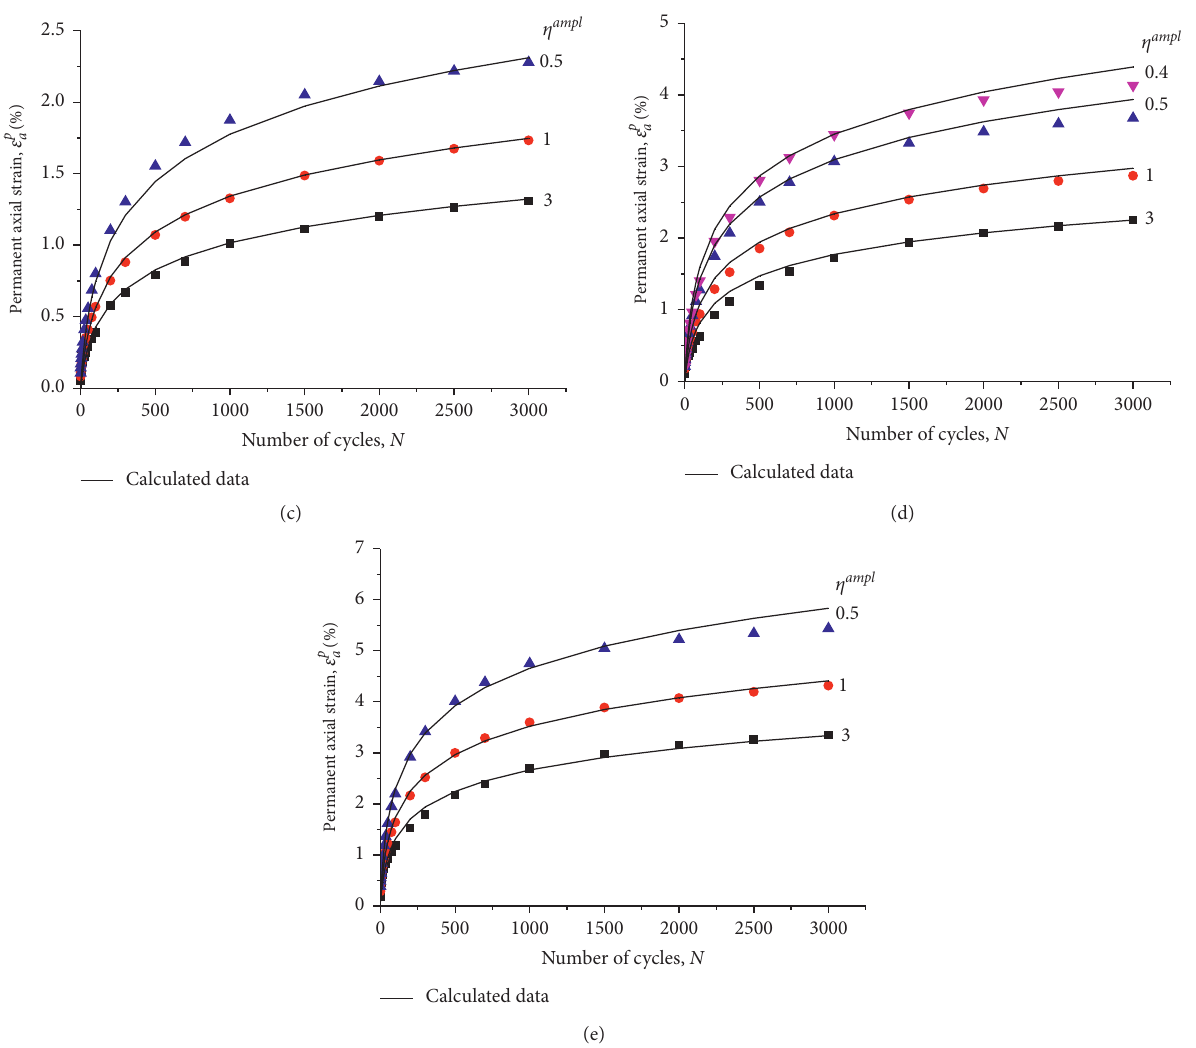
Figure 17: Comparison of the measured and calculated permanent axial strains. (a) CSR � 0.208. (b) CSR � 0.278. (c) CSR � 0.347. (d) CSR � 0.486. (e) CSR �